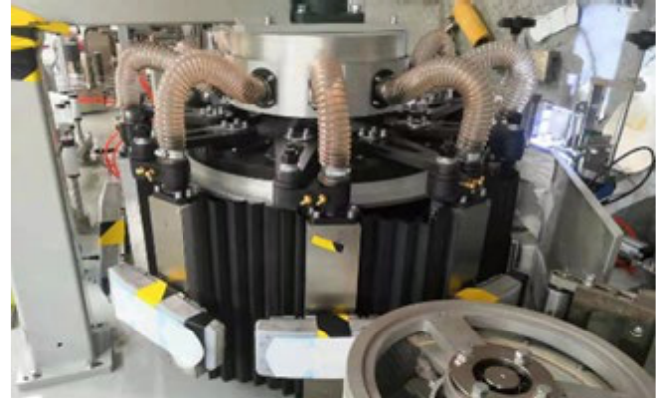
Figure 19. Comparison before and after cam optimization.